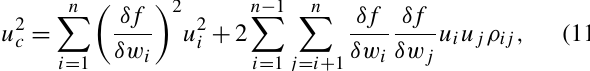
Figure 1. International ship routes in the Baltic Sea, the ship routes to the harbors of Helsinki, and modeled NO x emissions. Land area is marked using gray, sea is shown in white, and NO x emissions (in kg) are shown using color, as indicated by the color bar. Harmaja Island is marked using a red